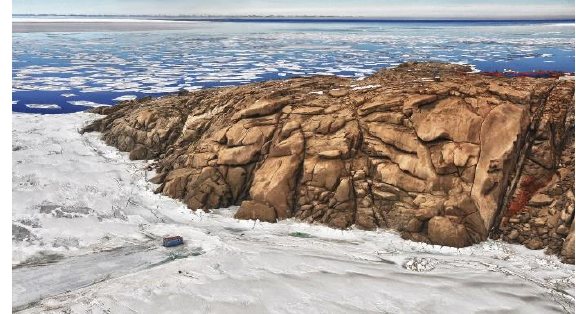
Figure 1. The study area, Tethys Bay (Ross Sea, Antarctica) during the first half of December with ice-pack still present.